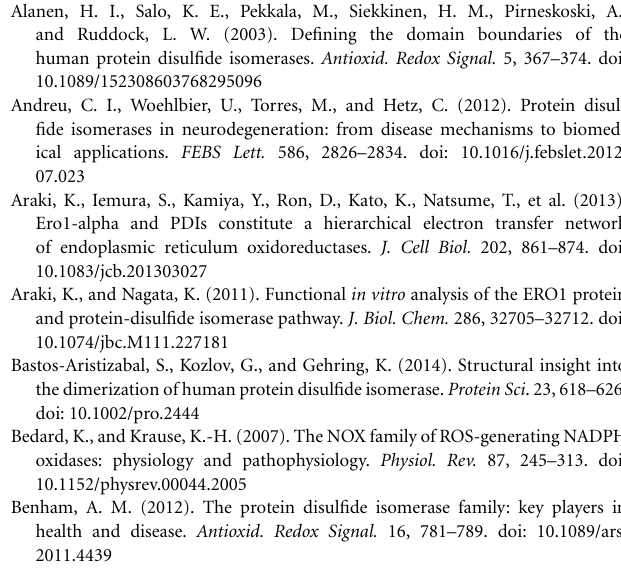
FIGURE 3 | The formation of NO + /NO from nitrite during hypoxic conditions by Hb and the transfer of nitric oxide to endothelium by PDI. (1) Nitrite reacts with Hb under hypoxic conditions to form Fe(II)-NO. (2) PDI from blood equilibrates across the plasma membrane of red blood cells to form a complex with Hb. (3) When red blood cells enter the lungs the O 2 displaces the NO from the iron on the heme group to PDI thiols or to Hb (Cys